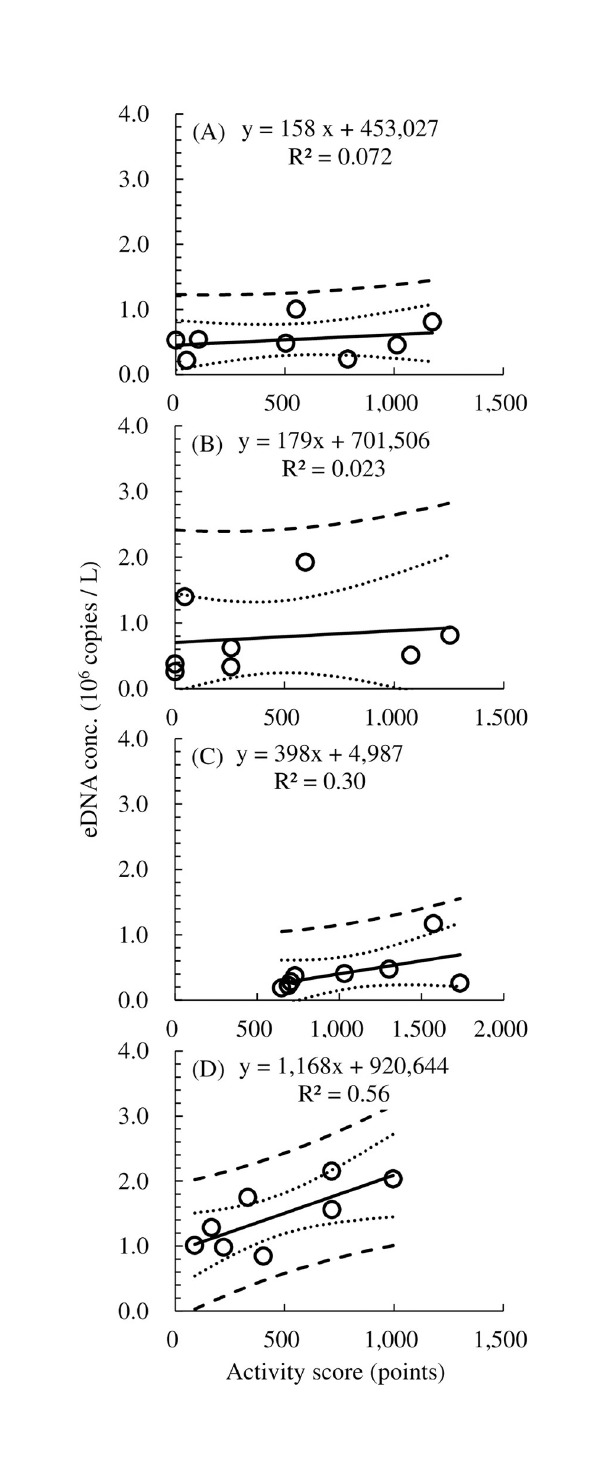
Fig 4. Correlation between eDNA concentration (eDNA conc.) and activity score 1 h before water sampling. (A) Aja-1, (B) Aja-2, (C) Aja-3, (D) Aja-4. Dotted lines indicate 95% confidence limits. Dashed lines indicate 95% prediction